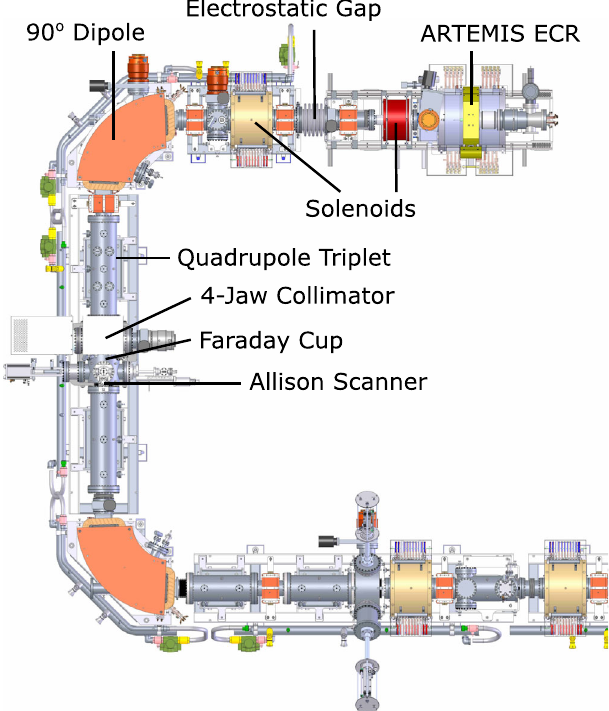
FIG. 11. Upstream end of the low energy beam transport (LEBT) line of the FRIB front end.